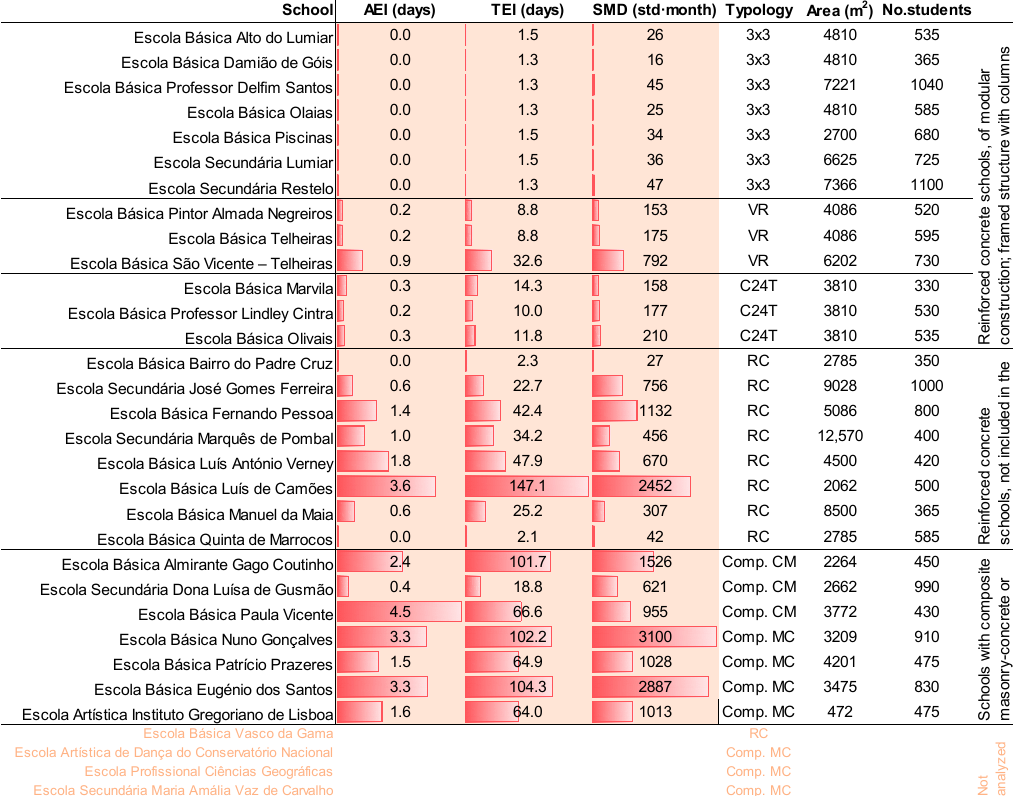
Figure 13. Expected number of interdiction days and “relocated students x month” indicator (SMD). Figures 13 and 14 show that four schools are expected to register a number of inter- diction days in 50 years above 3 months, while three other schools will be closed for more than 2 months in 50 years. Regarding the SMD indicator, three schools have a value greater than 2400. The values presented here can serve as a basis for developing a response plan for seismic events at the municipal